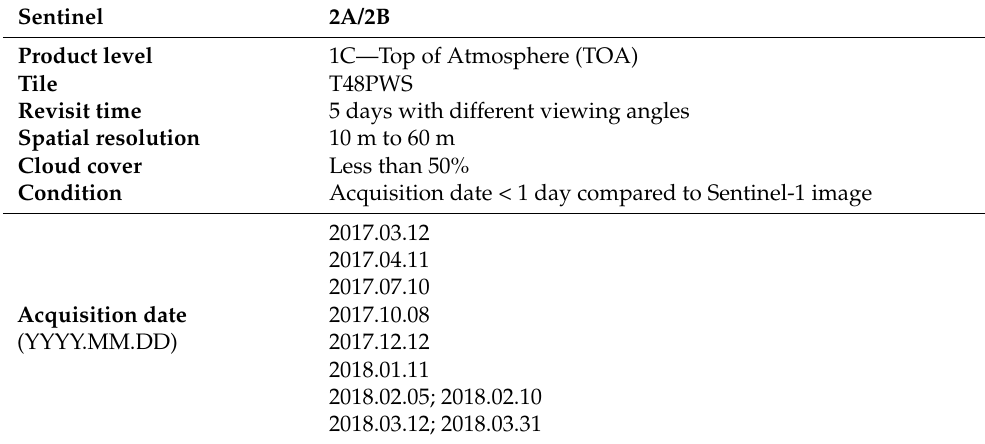
Table 2. Sentinel-2 data. The acquisition date is sorted by line corresponding to each month.